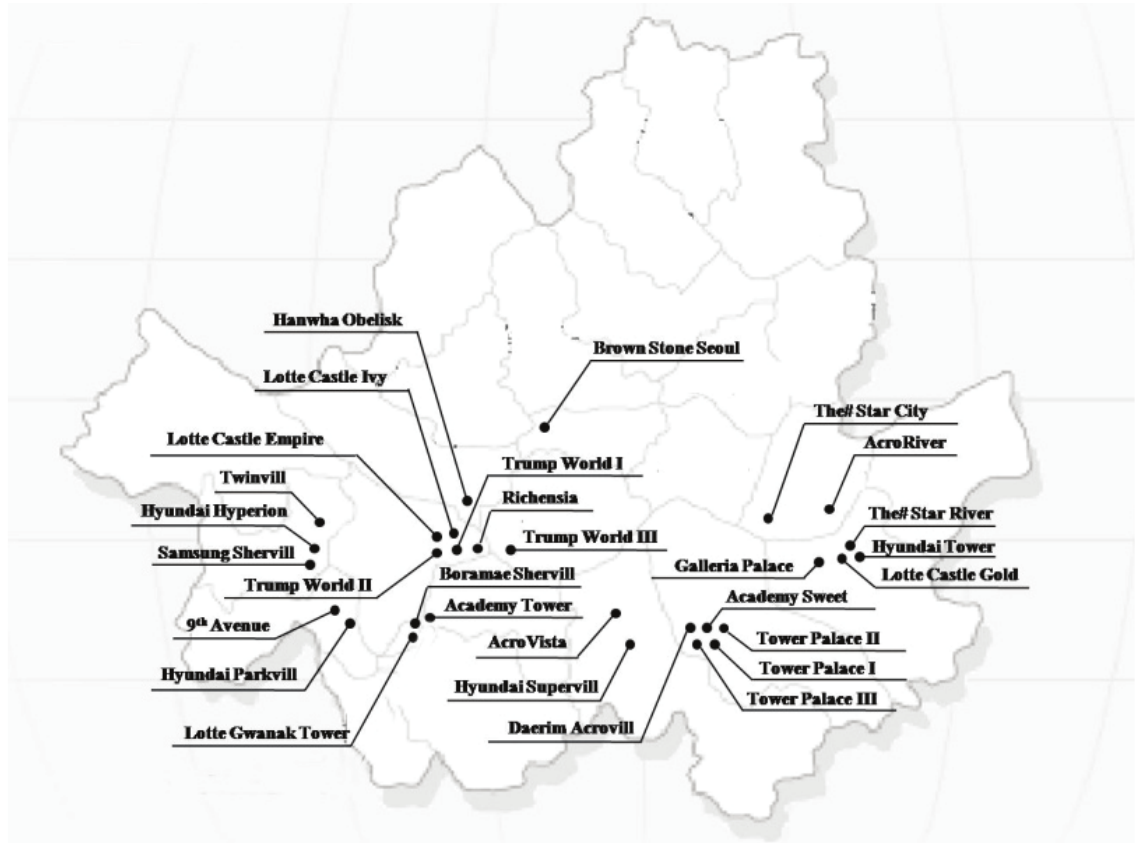
figure 1. location of super high rise residential buildings in